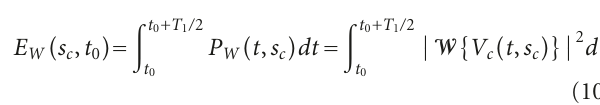
e ffi cient ρ s indicates agreement. A value near 1 indicates